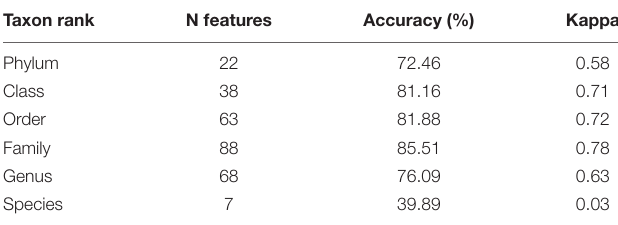
TABLE 2 | Accuracy of prediction of high, moderate, and low aquaculture-related impact using bacterial taxon ranks as features and impact category (obtained from macrofauna surveys) as reference